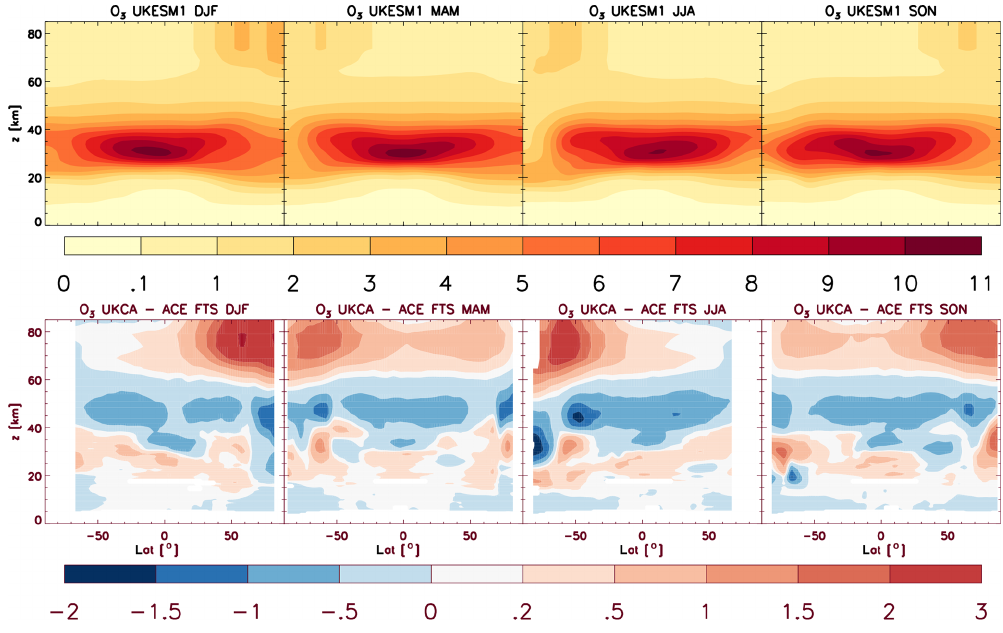
Figure 24. Same as Fig. 20 but for ozone (O 3 ;